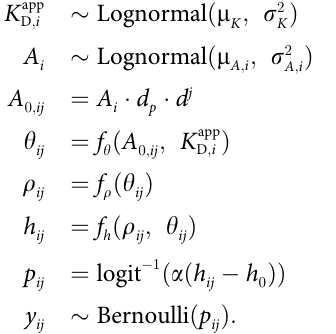
Table 1. The k posterior distribution was approximately log-normal (centered at around agg 2 � 10 6 s − 1 with 95% credibility interval of approximately 0.4 � 10 6 –13 � 10 6 s − 1 ) with slightly heavier tail towards larger k values since hemagglutination reaches saturation at approxi- agg mately 30 min (S1B Fig). Data at earlier time points would be needed to infer k precision. We set k = 2 � 10 6 s − 1 ; the precision suffices as we are interested in hemagglutina- agg tion at � 30